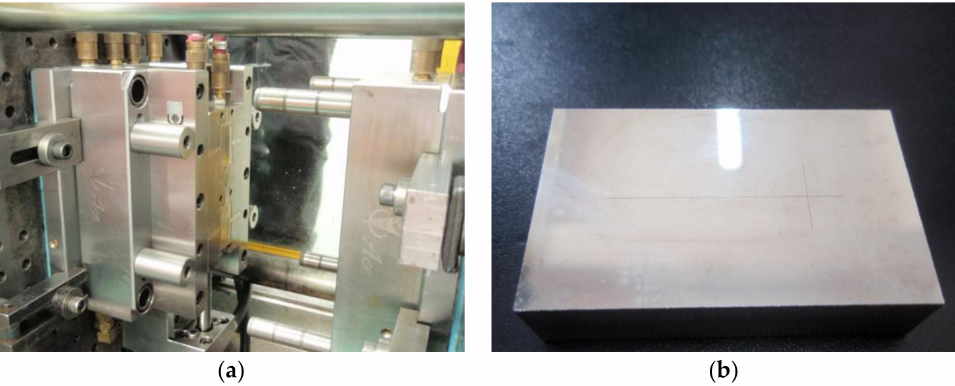
Figure 2. ( a ) The experimental mold of the microfluidic chip and ( b ) The mold insert of the